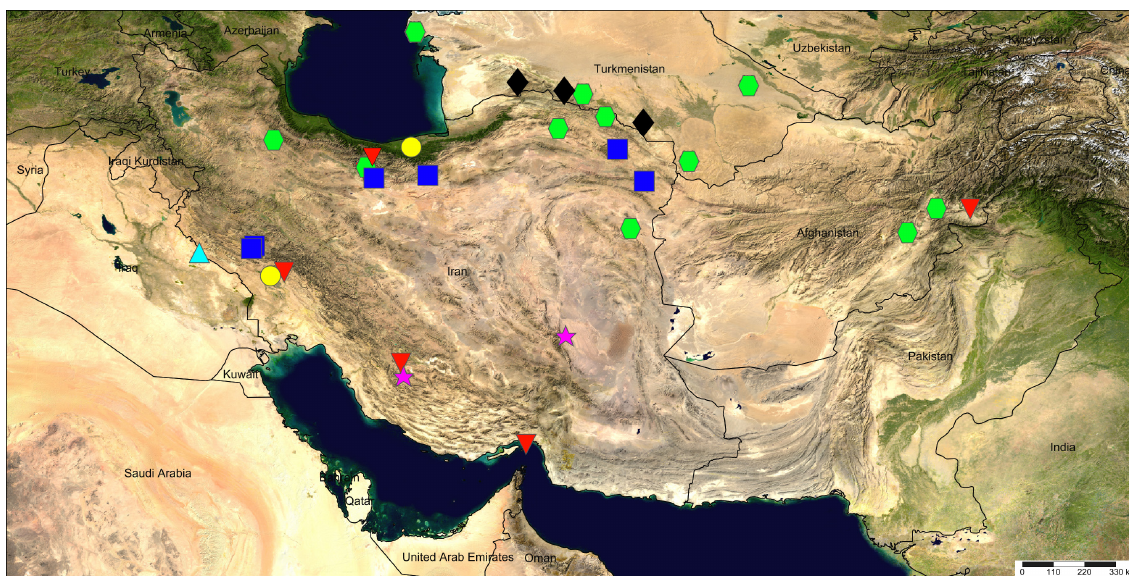
Fig. 1. Distribution of Oecobius Lucas, 1846 in Iran, Afghanistan and Turkmenistan. yellow circles = O . cellariorum (Duges, 1836; pink stars = O . fahimii Zamani & Marusik, 2018; blue squares = O . ferdowsii Mirshamsi, Zamani & Marusik, 2017; cyan triangle = O . ilamensis Zamani, Mirshamsi & Marusik, 2017; green hexagons = O . nadiae (Spassky, 1936); red triangles = O . putus O. Pickard- Cambridge, 1876; black diamonds = O . tadzhikus Andreeva & Tyschchenko, 1969.